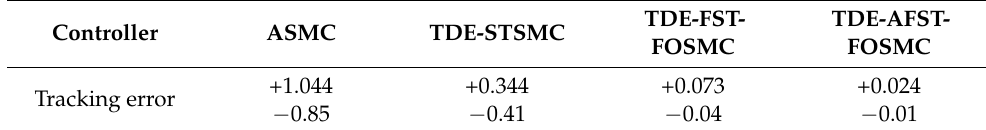
Table 5. Steering wheel angle tracking errors of controllers in the DLC test.